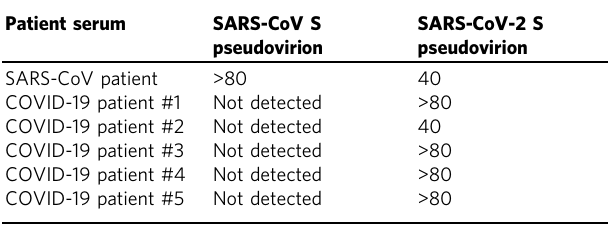
SARS-CoV and SARS-CoV-2 S pseudovirions were pre-incubated with serially diluted patient sera for1h onice, then virus-antibodymixturewas addedon 293/hACE2cells. Cellswere lysed 40h later and pseudovirus transduction was measured. The highest dilution of the serum samplethat decreasedtransduction by50% ormore wasconsidered tobe positive.Source data are provided as a Source Data fi